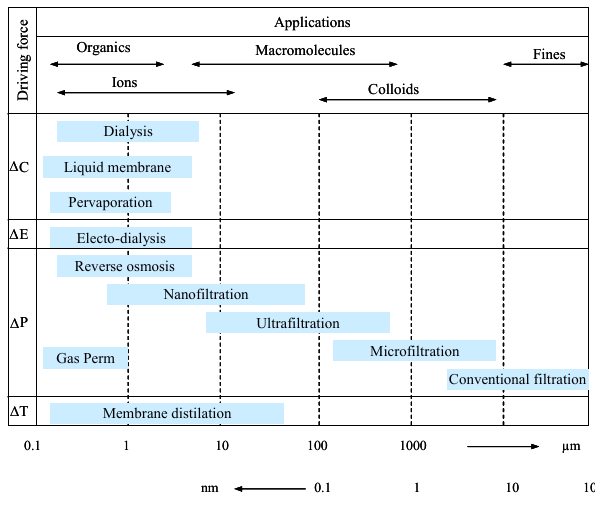
Figure 1 Effective range of membrane processes Figure 1. E ff ective range of membrane